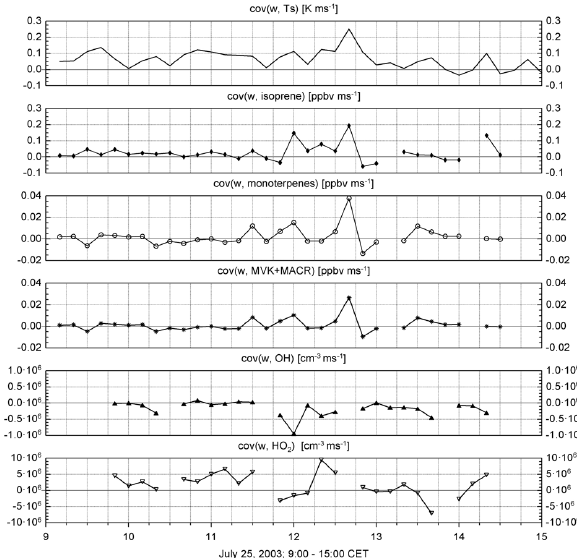
Fig. 7. Covariances (fluxes) of sensible heat, isoprene, sum of monoterpenes, MVK + MACR, OH and HO 2 at 37m height for 25 July 2003, 09:00–15:00CET.